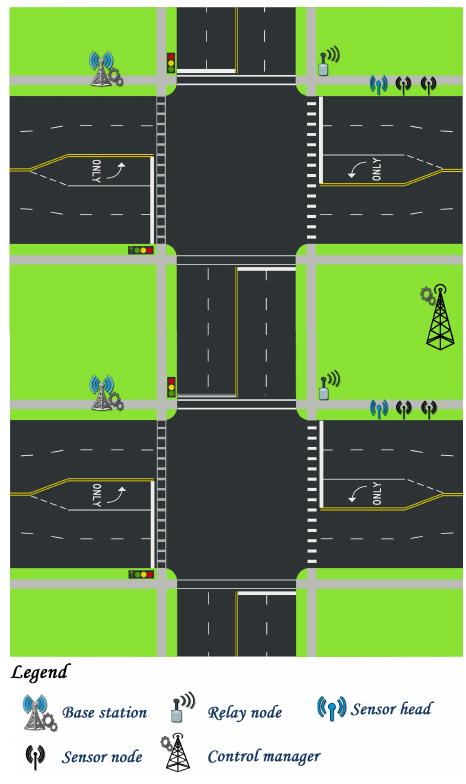
Figure 5. Major components of the proposed